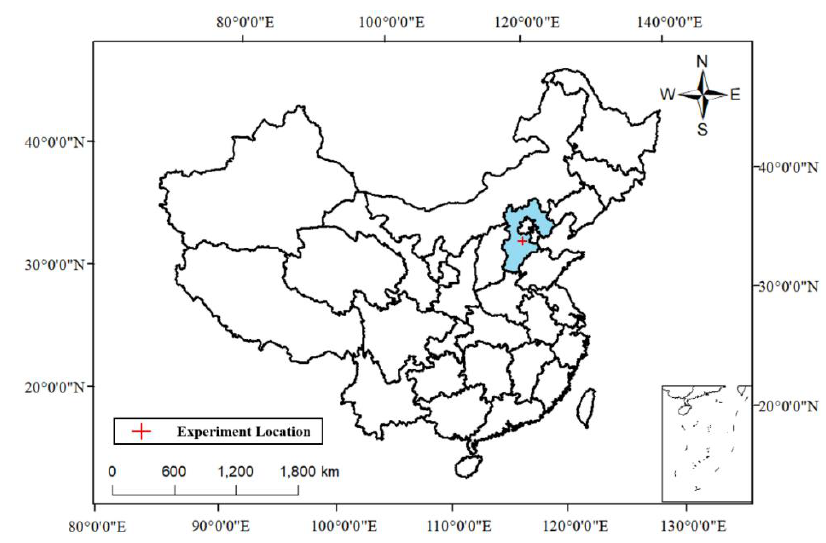
Figure 2. The location of the experiment site.